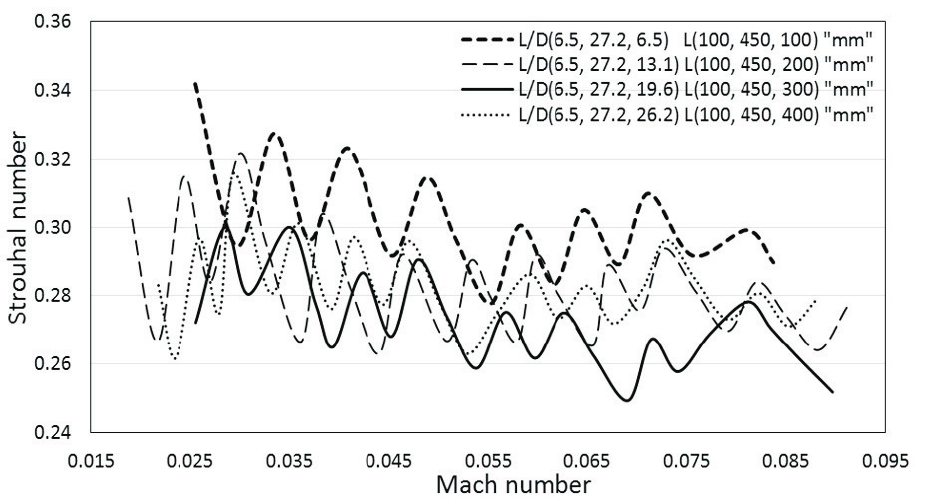
Figure 12. Strouhal number St plotted against Mach number M for L up = 100 mm, L corr = 450 mm, and L dw = 100–400 mm. Table 8. Mach number range, corresponding Strouhal number ( St ) range and maximum Strouhal number for each pipe configuration in Case